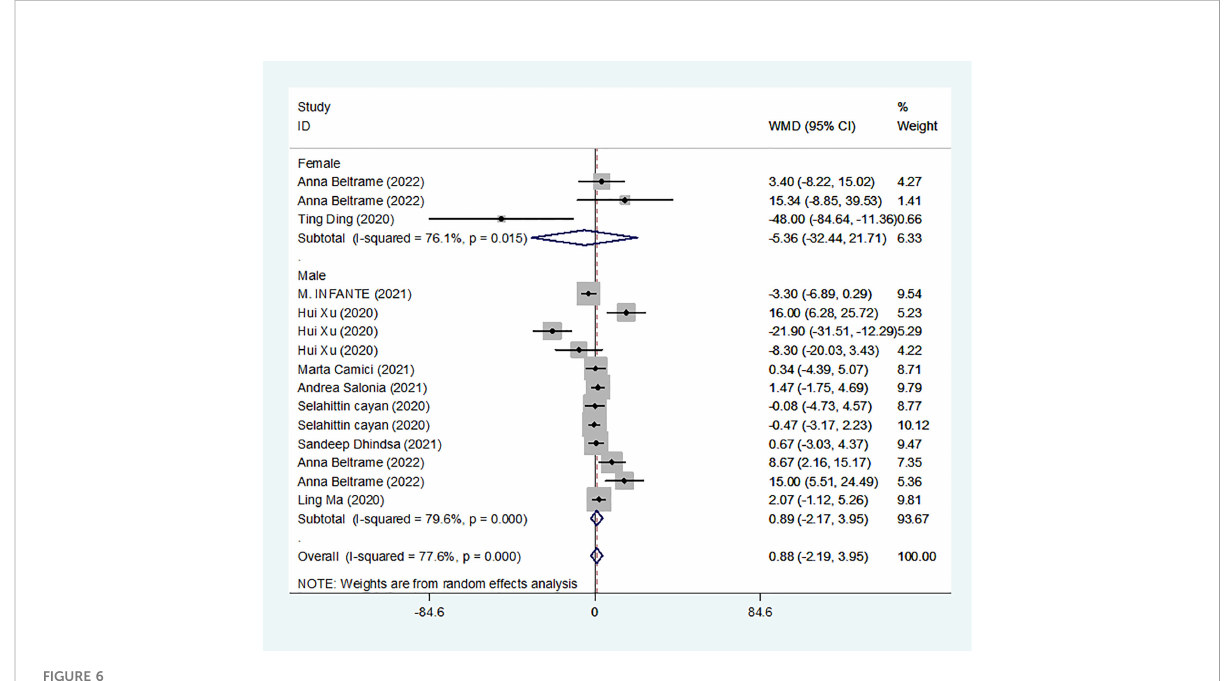
FIGURE 6 E 2 levels in people with COVID-19 versus those without